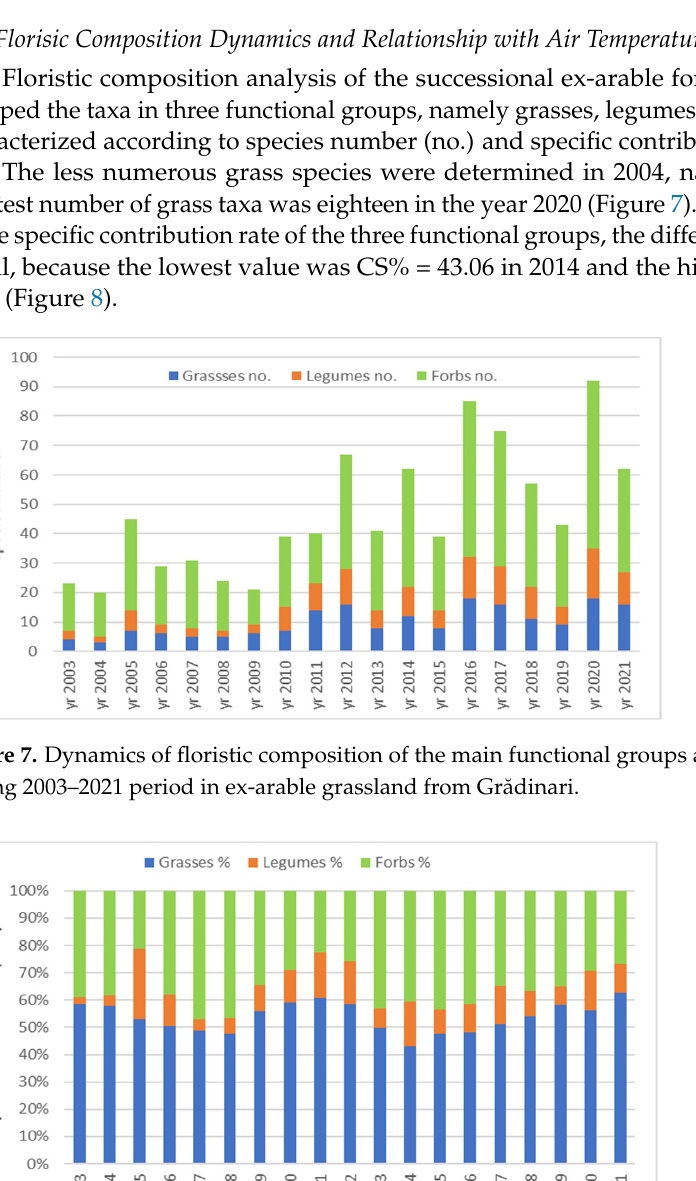
Table 2. Correlations between the rainfall amounts (I–XII) and species biodiversity (S, H (cid:48) and D) in ex-arable grassland from Gr ă dinari (period 2003–2021).